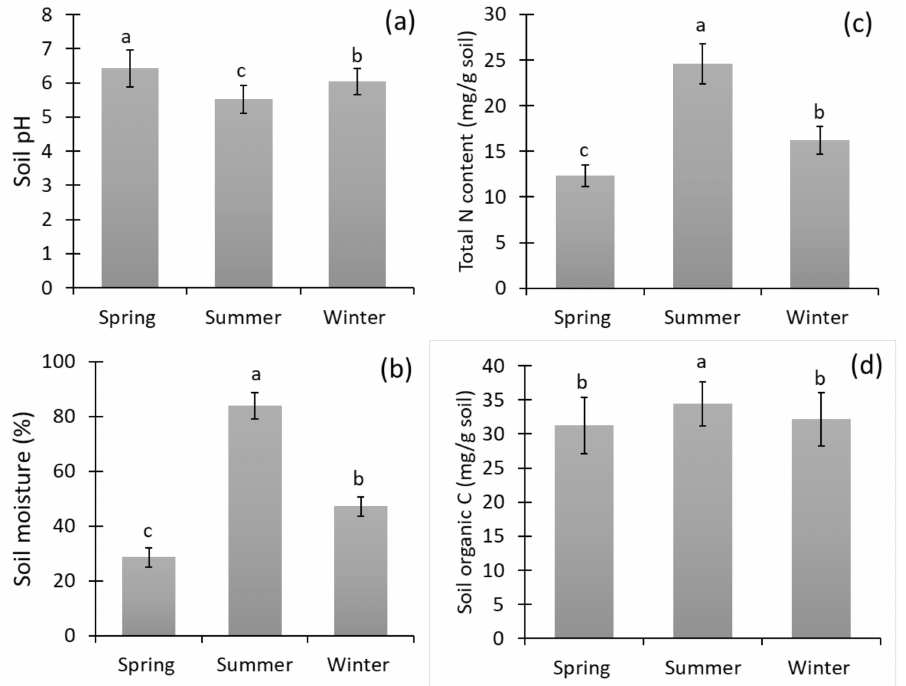
Figure 2. The soil pH ( a ), moisture content ( b ), total nitrogen content ( c ), and total carbon content ( d ) of the soil samples of the rice fields during the three seasons of the year. Bars represent the mean of 72 soil samples ( ± SD) and different letters on the bars show the significance at p ≤ 0.05 among the different